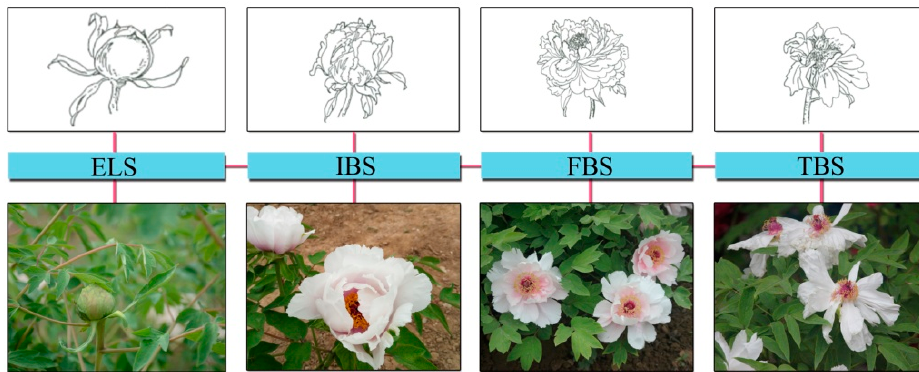
Figure 2. Morphological characteristics of peony flowers at the different stages. ELS: exhibition leaf stage, IBS: initial bloom stage, FBS: full bloom stage, and TBS: terminal bloom stage.